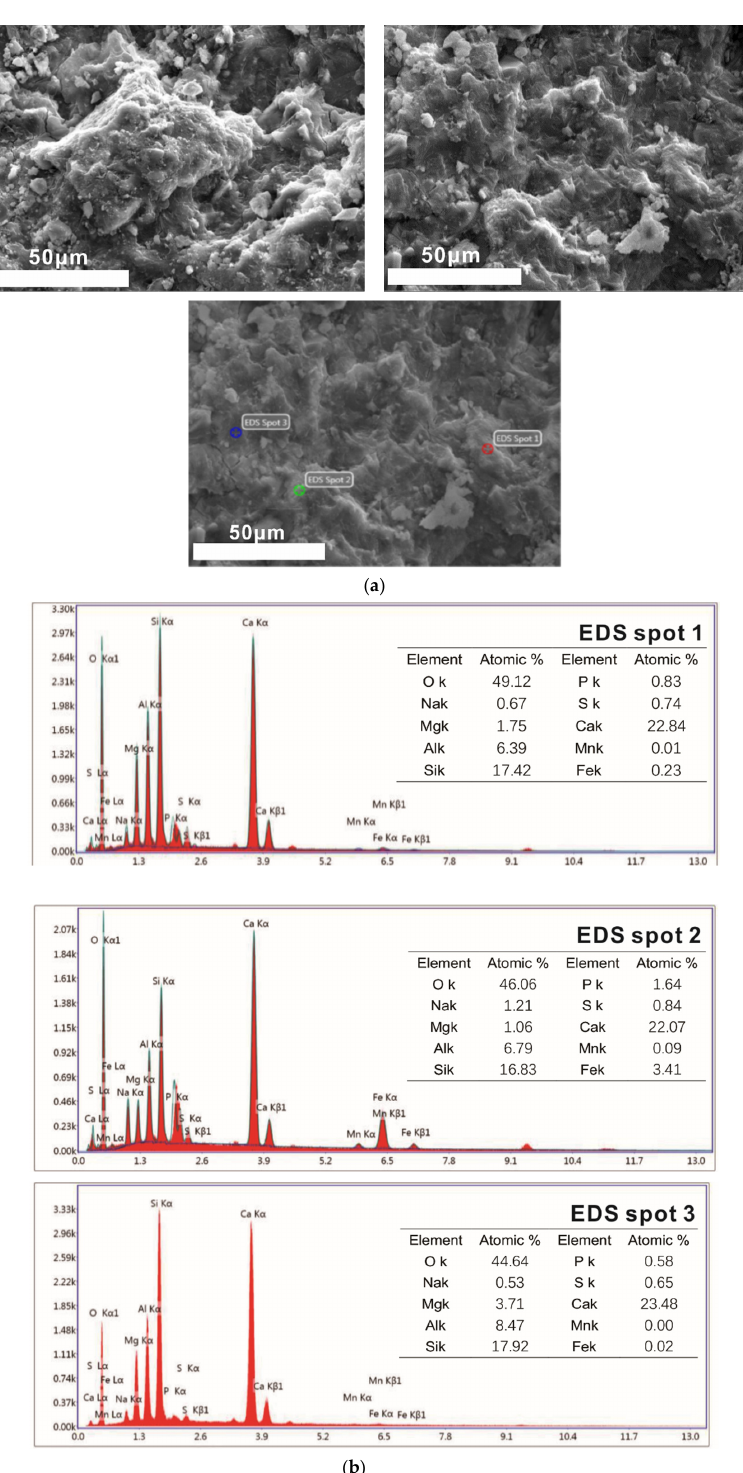
Figure 11. SEM-EDS of 28 days of curing samples. ( a ) SEM images of 28 days of curing samples. ( b ) EDS images of local region.